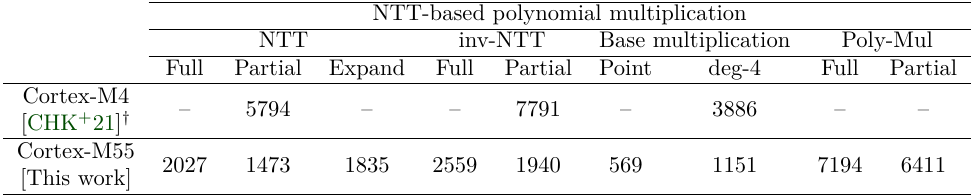
Table 3 Comparing different stages of NTT multiplication for Saber. “Expand” is the NTT-variant discussed in Section 6.4.4.